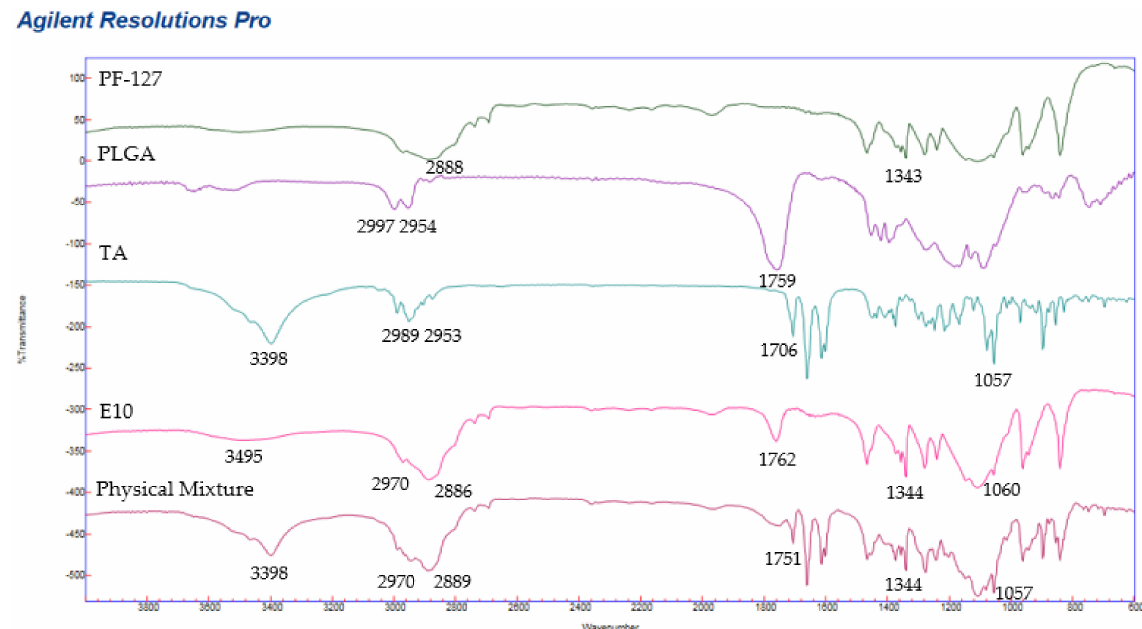
Figure 7. FTIR spectrums of individual components (TA, PLGA and PF-127), physical mixture and PLGA nanoparticles (E10). Table 4. Representation of FT-IR peaks and functional groups of the individual components, physical mixture and PLGA NPs (E10). Frequency (cm − 1